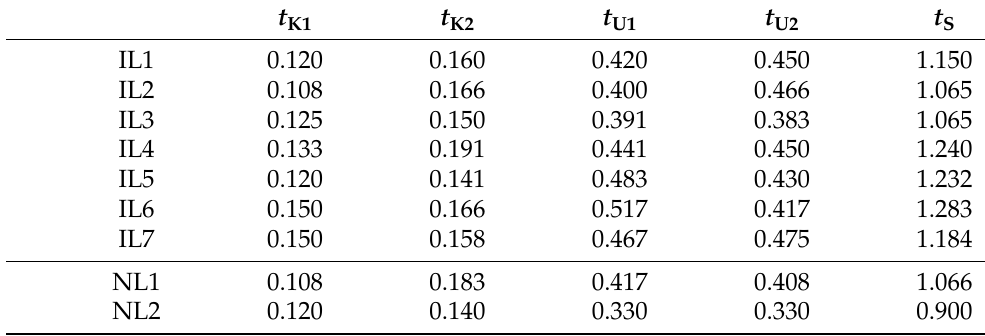
Table 2. Experimental data for swimmers IL1–IL7 and NL1–NL2: leg phase durations (in seconds). t